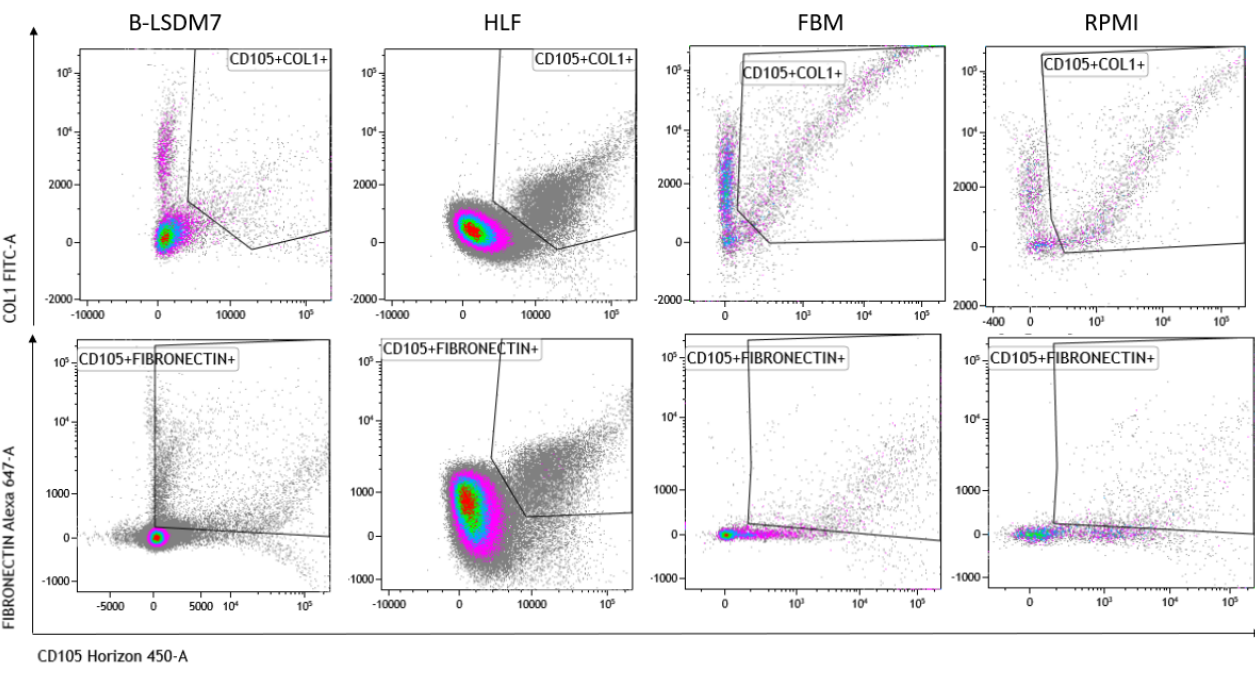
Figure 5. The Flow cytometric analysis of viability in B-LSDM7 and HLF cell lines. Fixable Viable Dye was used for the detection of dead/live cells.